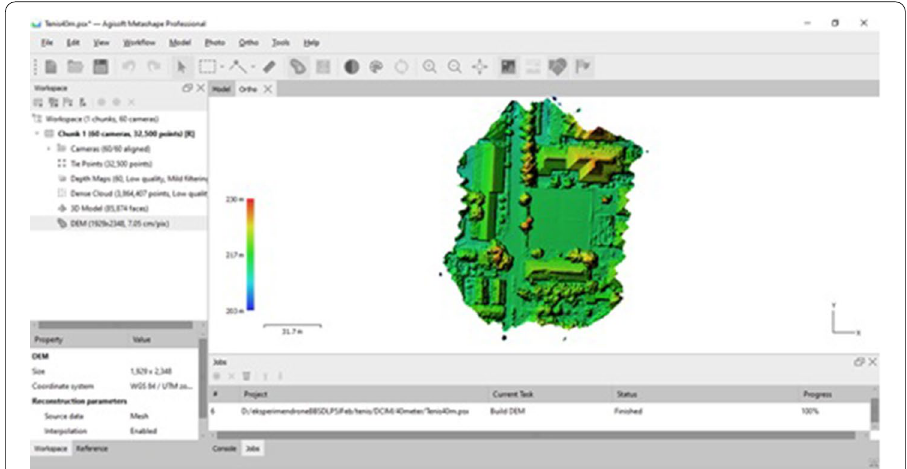
Fig. 5 Result of building DEM (Digital Elevation Model)